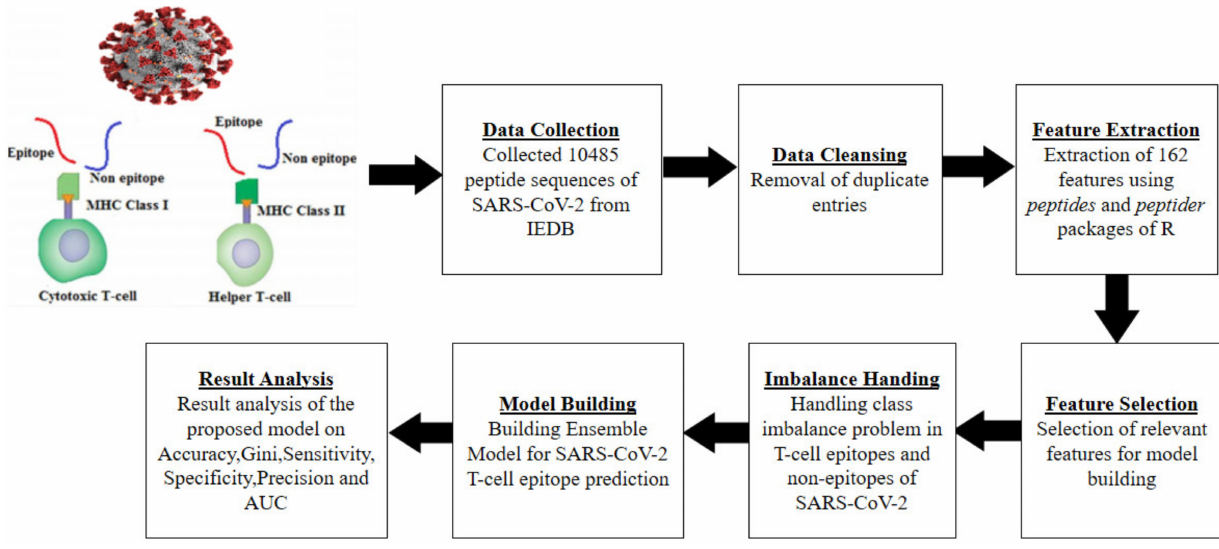
Figure 1. Proposed